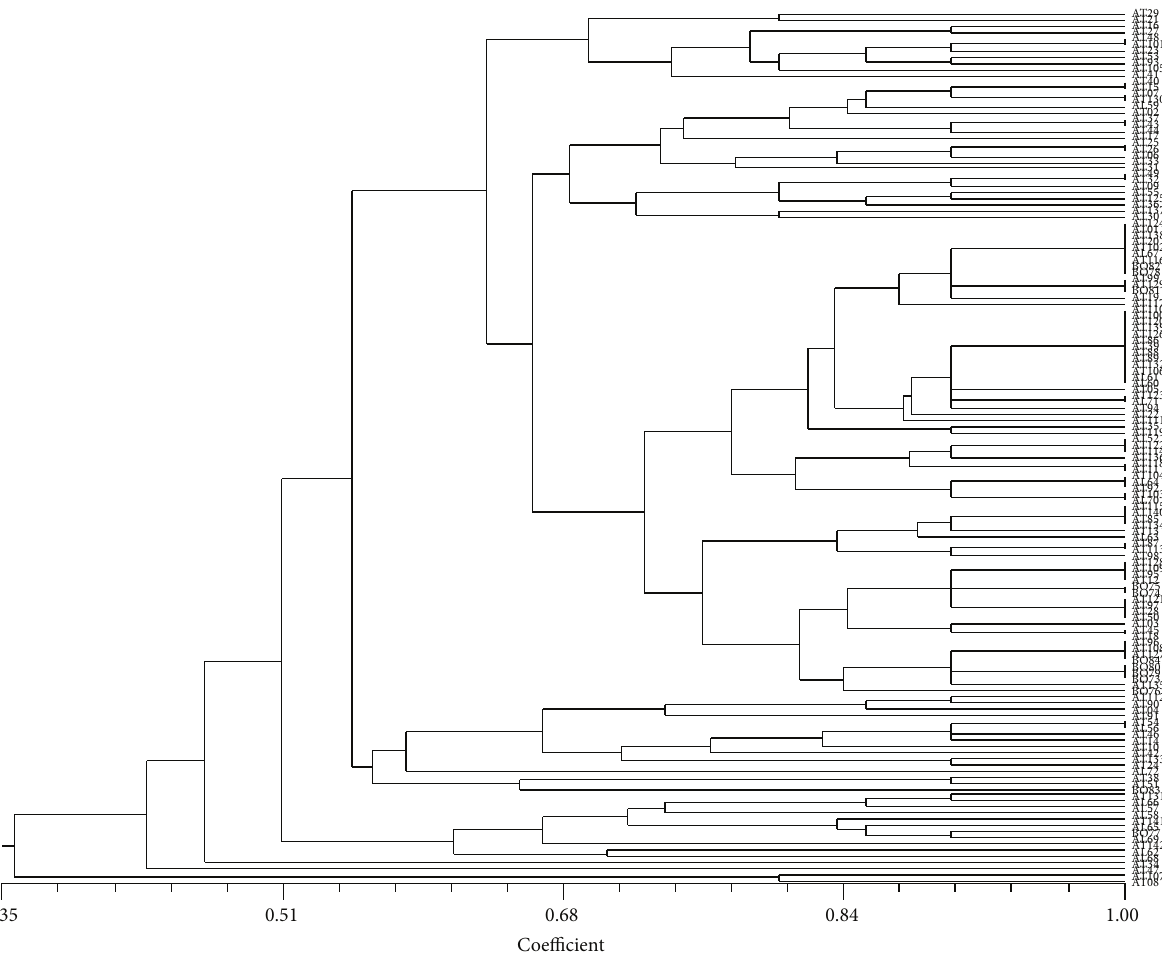
Figure 3: Classification of Benin sorghum accessions into 89 morphotypes using 10 qualitative traits and UPGMA clustering method.